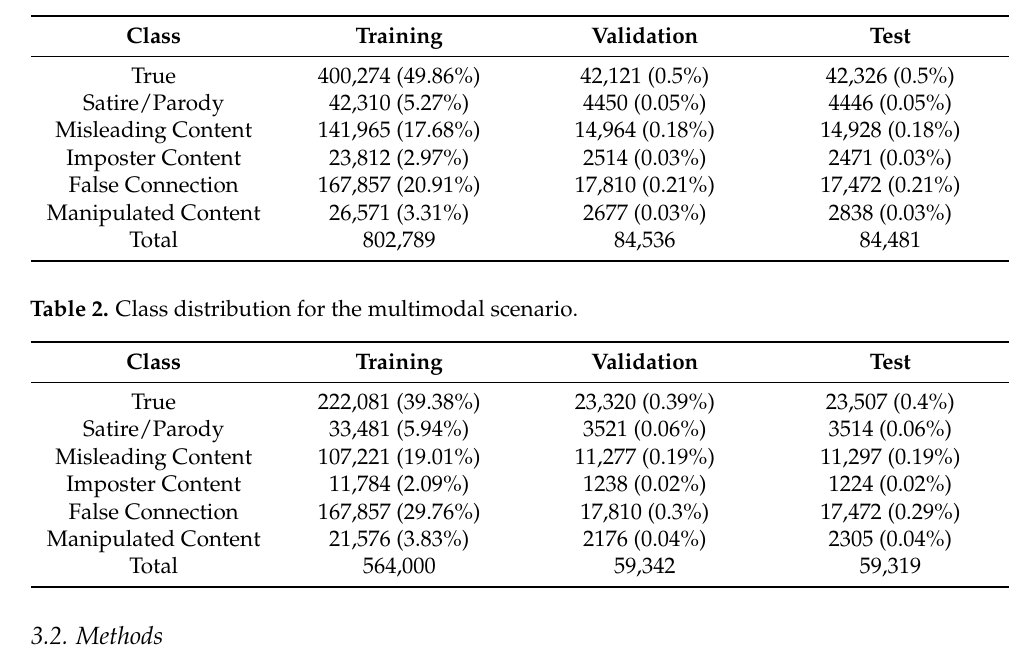
Table 1. Class distribution for the unimodal scenario.